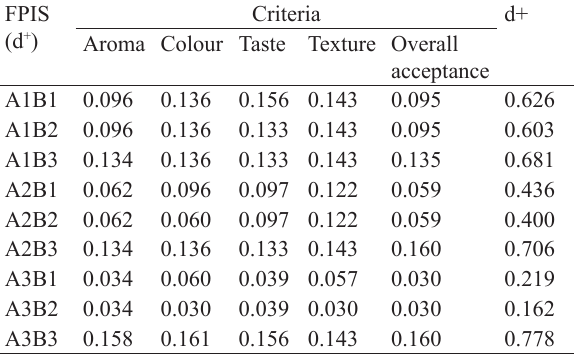
Table 13 Intervals between criteria value and FPIS Table 14 Interval between criteria value and FNIS